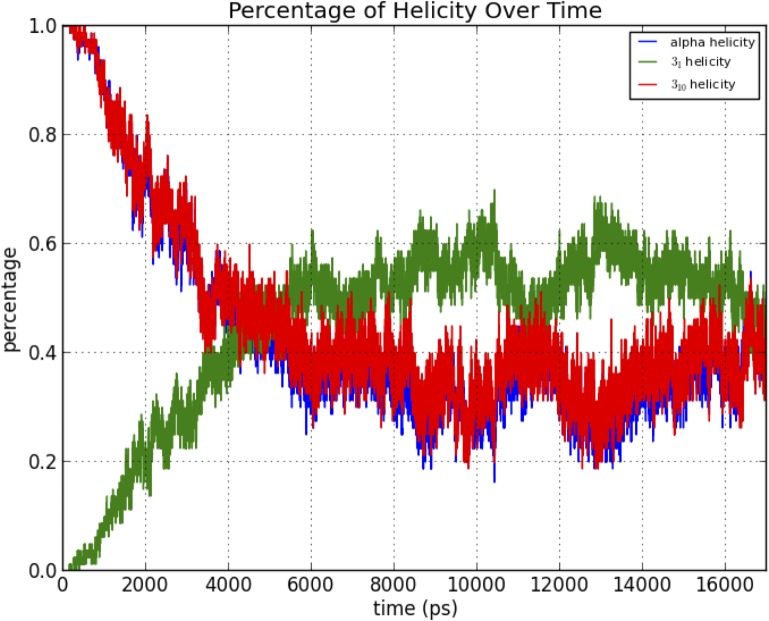
Transition of oligoalanine from its starting α-helical conformation to intermediate states that includes near α-, 310- and polyglycine conformations.